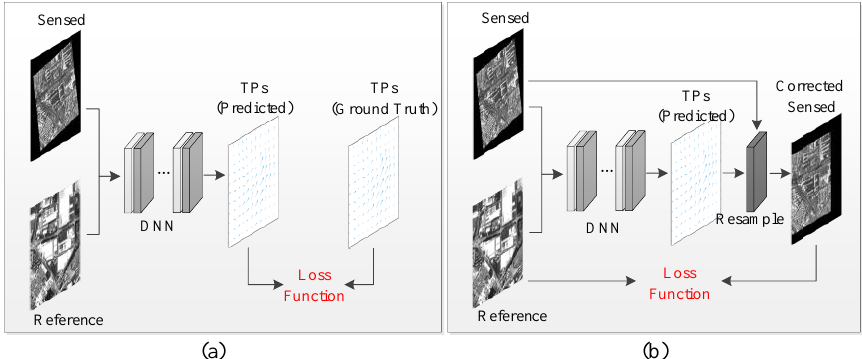
Figure 1. General architecture of (a) supervised methods and (b) unsupervised methods for end-to-end image